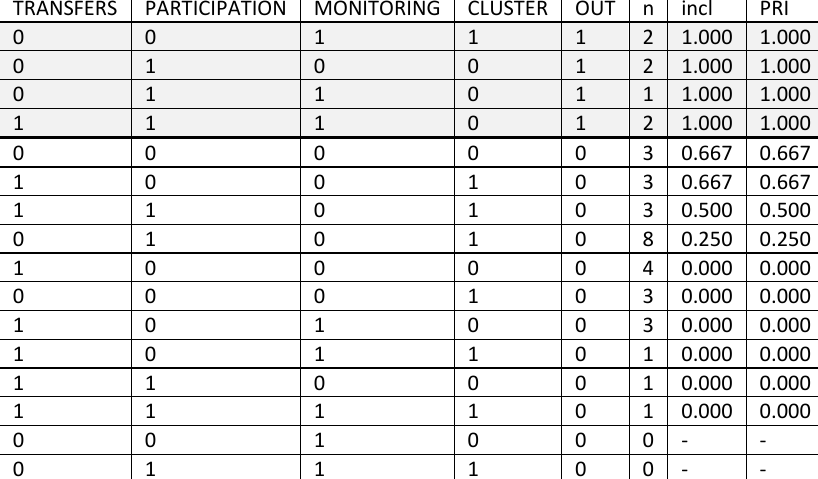
Table A2.7 Truth table for analysis of sufficiency for unsuccessful drought adaptation (OUTCOME=0)